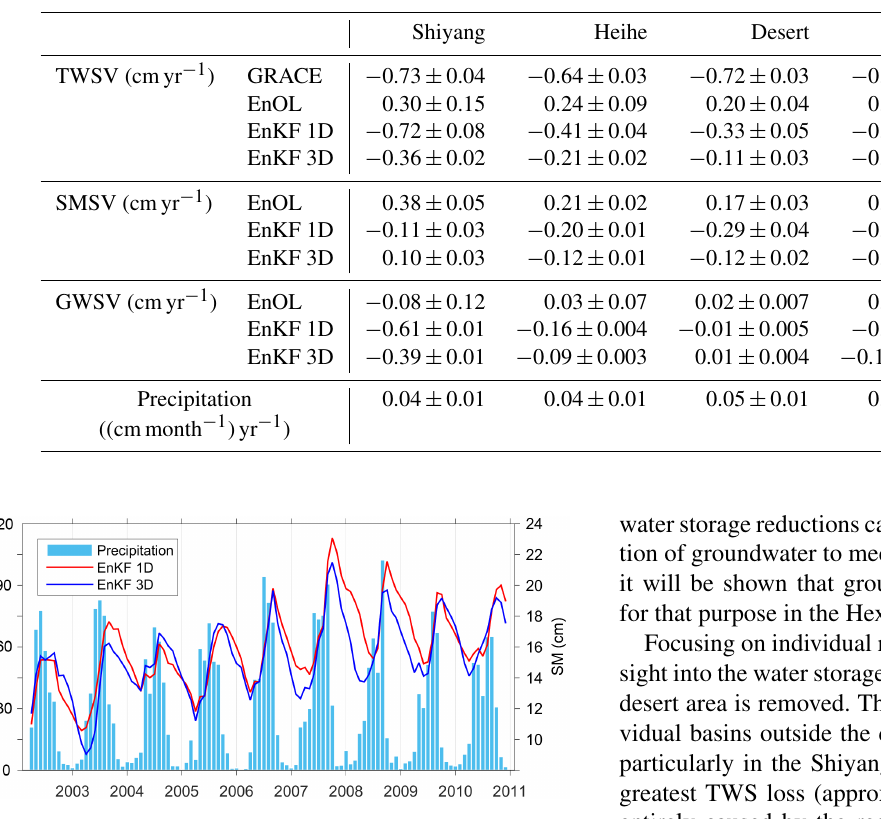
Figure 14. Monthly total precipitation (mmmonth − 1 ) and SM stor- age estimates (cm) from EnKF 1D and EnKF 3D results at the river gauge G2